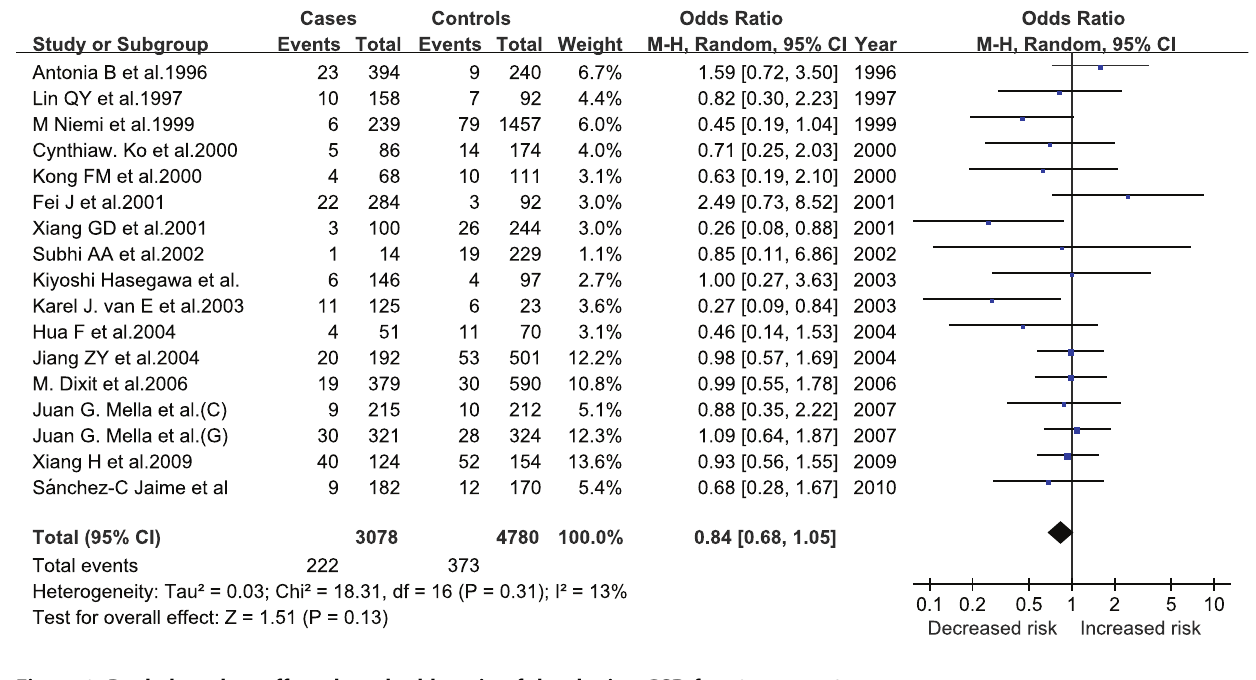
Figure 2. Pooled random-effects-based odds ratio of developing GSD for e 2 versus e 3.